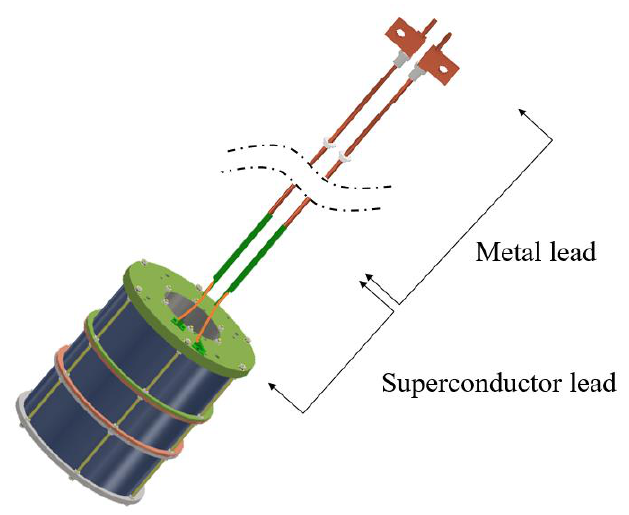
Figure 2. Structure of hybrid current leads.